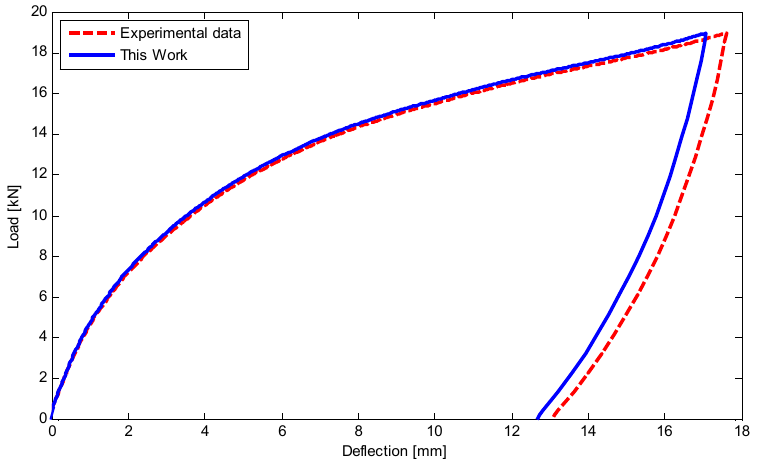
Figure 21. Comparison of load versus deflection for a circular SMA beam subjected to four-point bending test with force about 19 kN at room temperature.